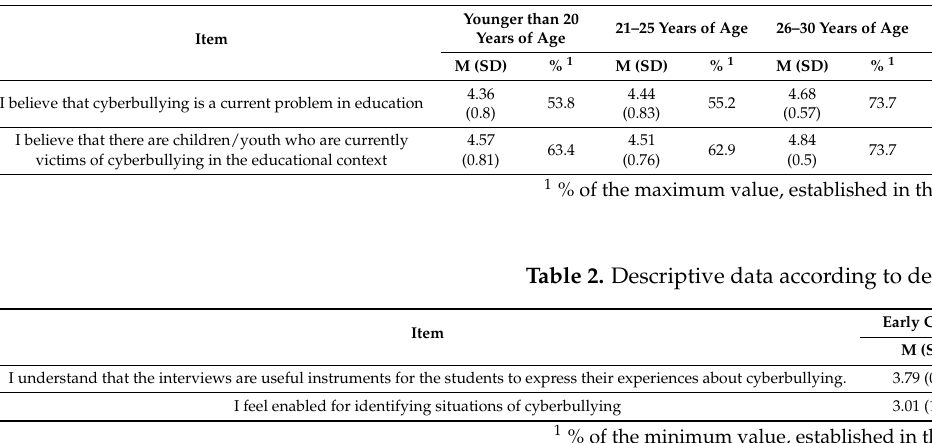
Table 1. Descriptive data according to age.